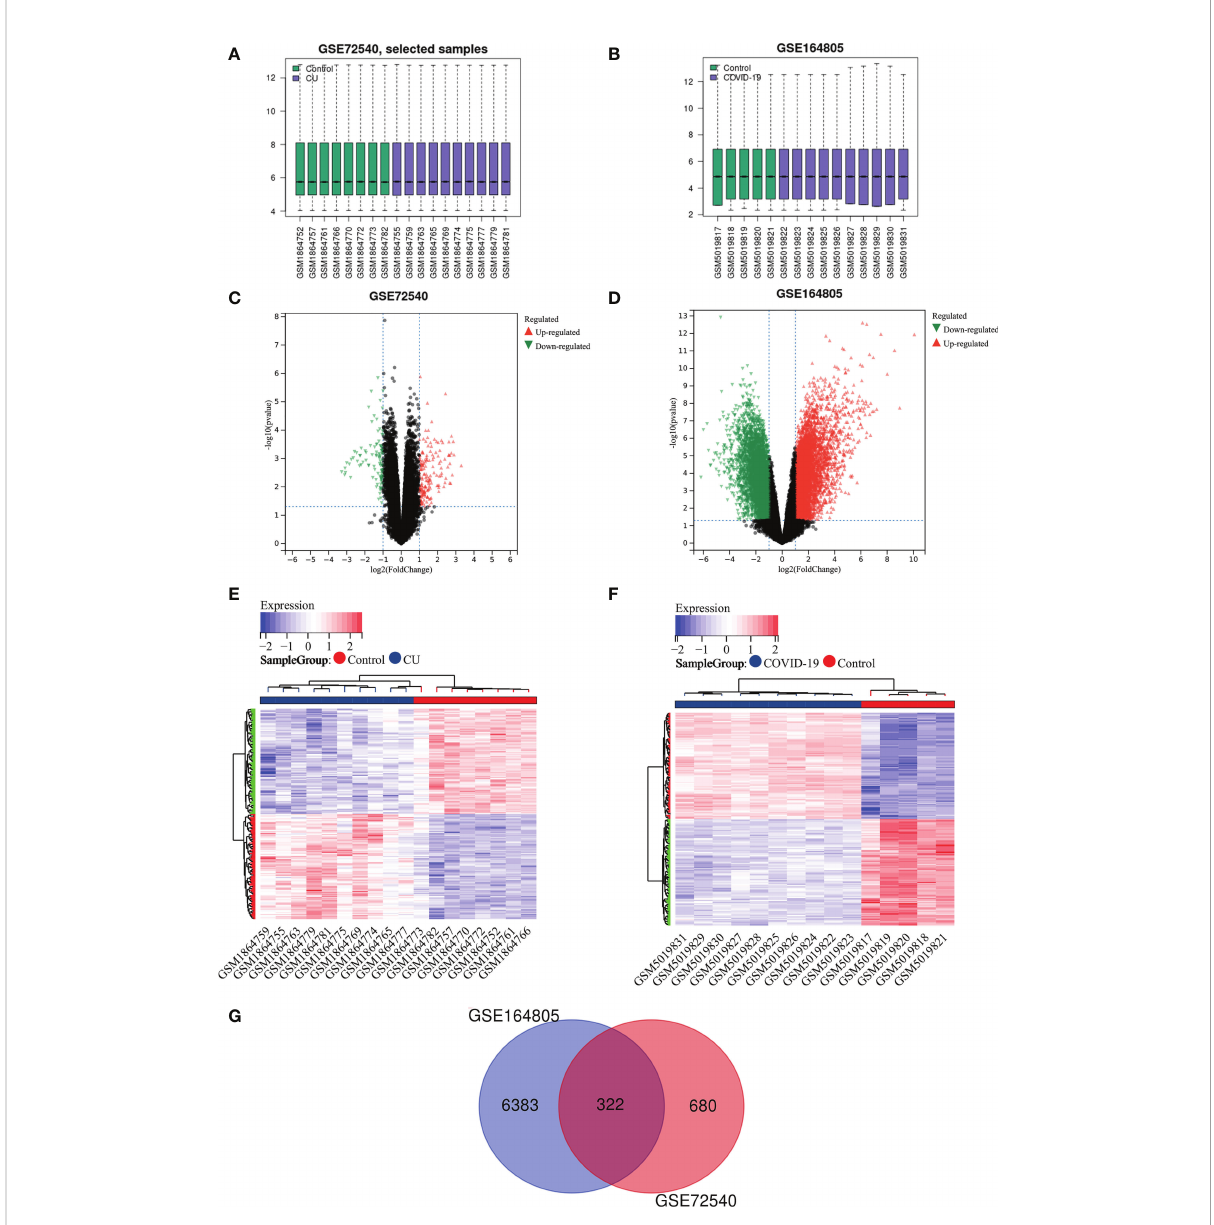
FIGURE 2 Recognition of shared DEGs between COVID-19 and CU. (A) Data standardization of GSE72540. (B) Data standardization of GSE164805. (C) The volcano plot of GSE72540. (D) The volcano map of GSE164805. (E) The heat map of the top 100 DEmRNAs of GSE72540. (F) The heat map of the top 100 DEmRNAs of GSE164805. (G) The shared DEGs between COVID-19 and CU by overlapping